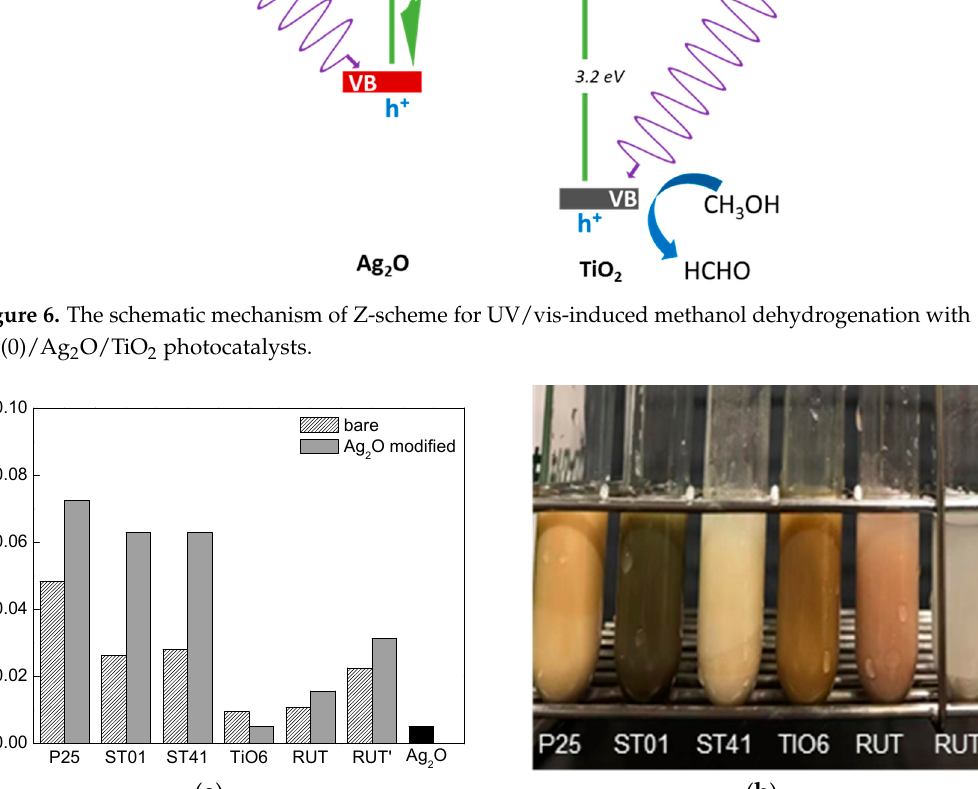
Figure 8. The schematic mechanisms of oxidative decomposition of acetic acid under UV/vis irradiation with Ag 2 O/TiO 2 photocatalysts: Z-scheme for anatase ( a ) and heterojunction (type II) for rutile ( b ). 3.2.3. Visible Light Photocatalytic Activity The vis photocatalytic activity of the obtained Ag 2 O/TiO 2 composites was investigated for two reactions: (1) Oxidative decomposition of phenol and (2) oxidation of 2-propanol. Obtained data are shown in Figures 9 and 10. ( a ) ( b ) Figure 9. Change in phenol ( a ) and benzoquinone ( b ) concentrations during vis irradiation ( λ > 400 nm) of Ag 2 O/TiO 2 photocatalysts.